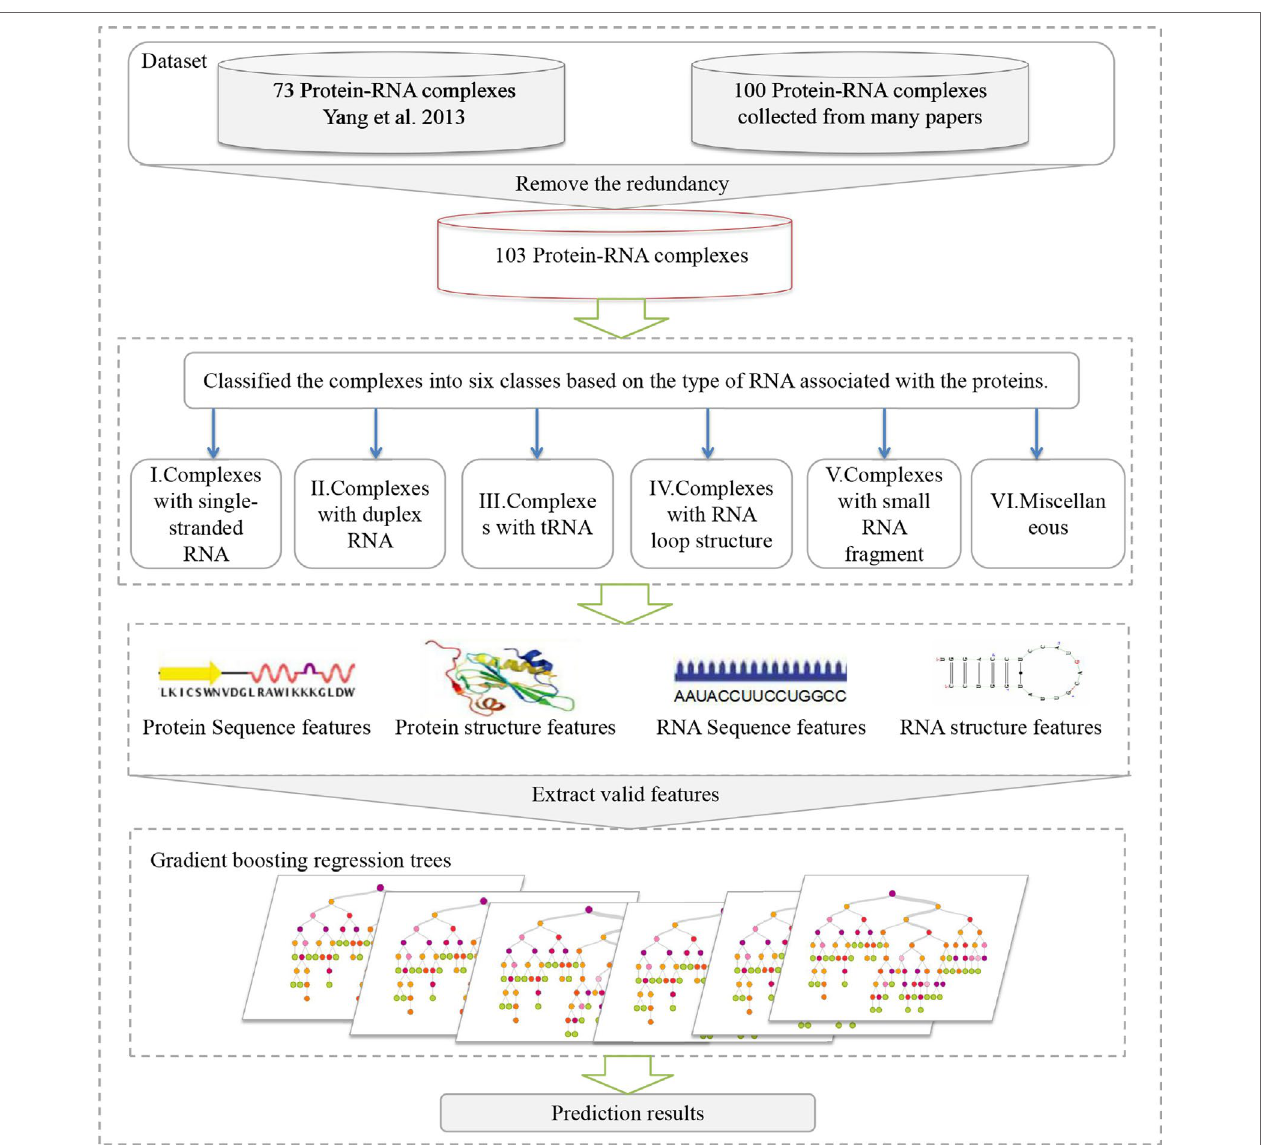
FIGURE 1 | The flowchart of the PredPRBA method for predicting the binding affinity of protein-RNA complexes. It involves four steps: (A) collection of complexes with experimentally measured binding affinities from publications. (B) Classification of complexes according to the type of RNAs interacting with proteins. (C) Feature extraction from sequence and structure from proteins and RNAs for building a predictive model. (D) Training gradient boosting regression tree